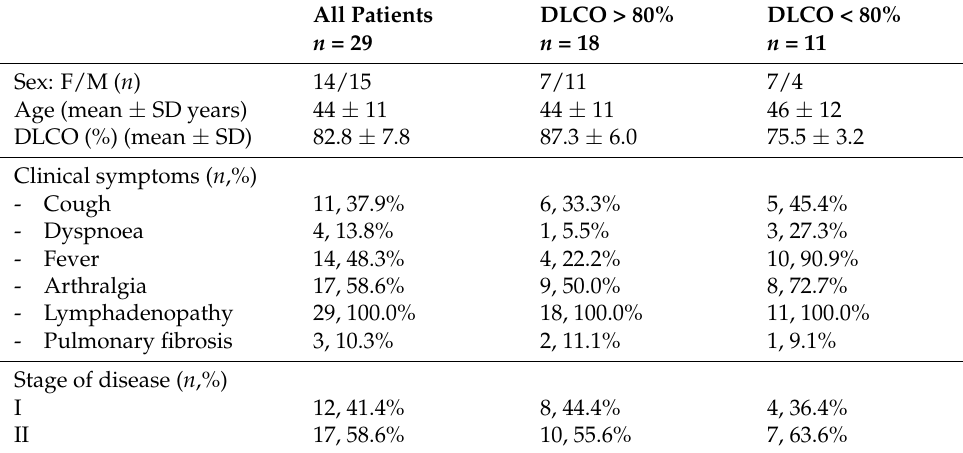
Table 1. Characteristic of the study population with